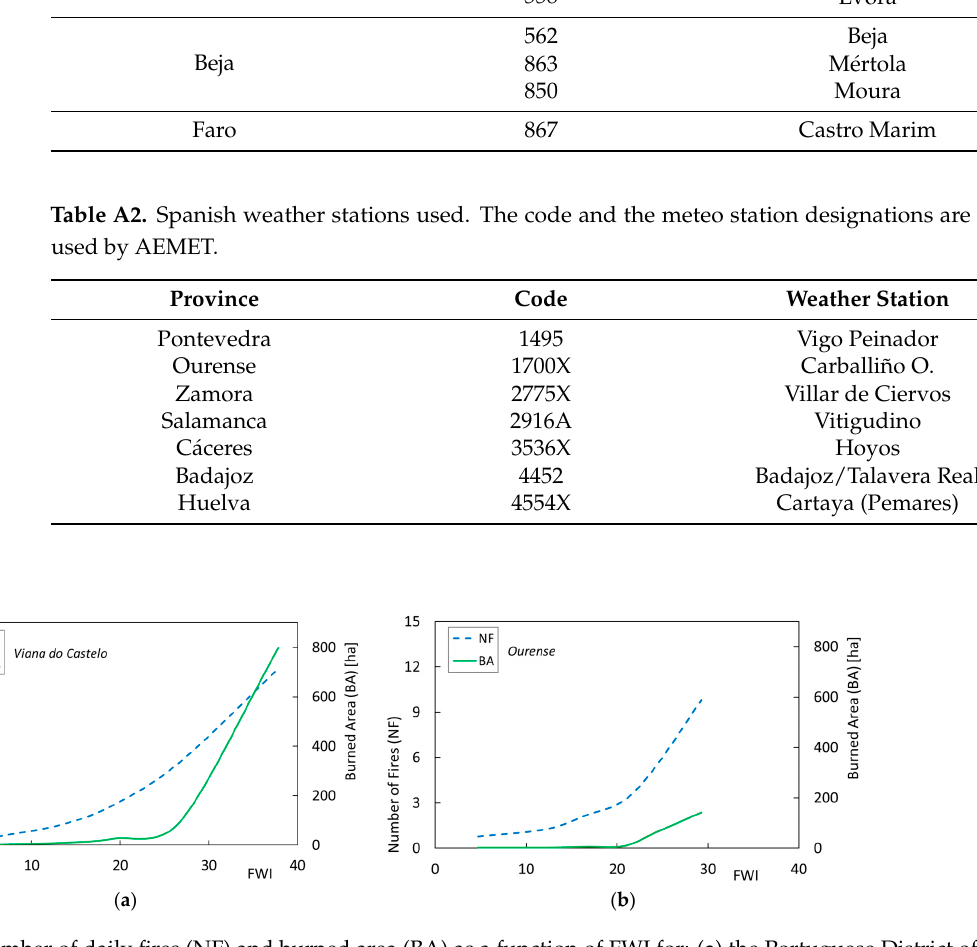
Figure A1. Average number of daily fires (NF) and burned area (BA) as a function of FWI for: ( a ) the Portuguese District of Viana do Castelo and ( b ) the Spanish Province of Ourense.